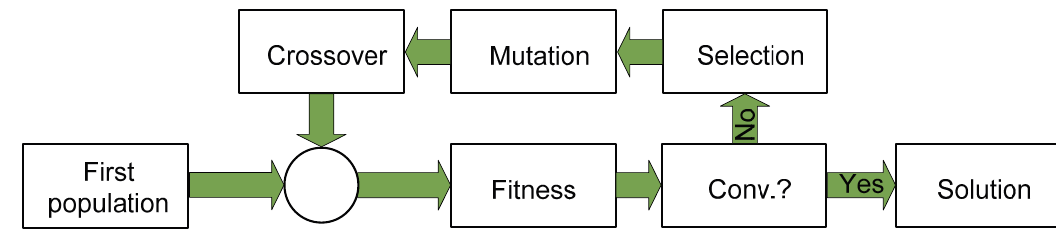
Figure 5. Block diagram of the genetic algorithm performance.